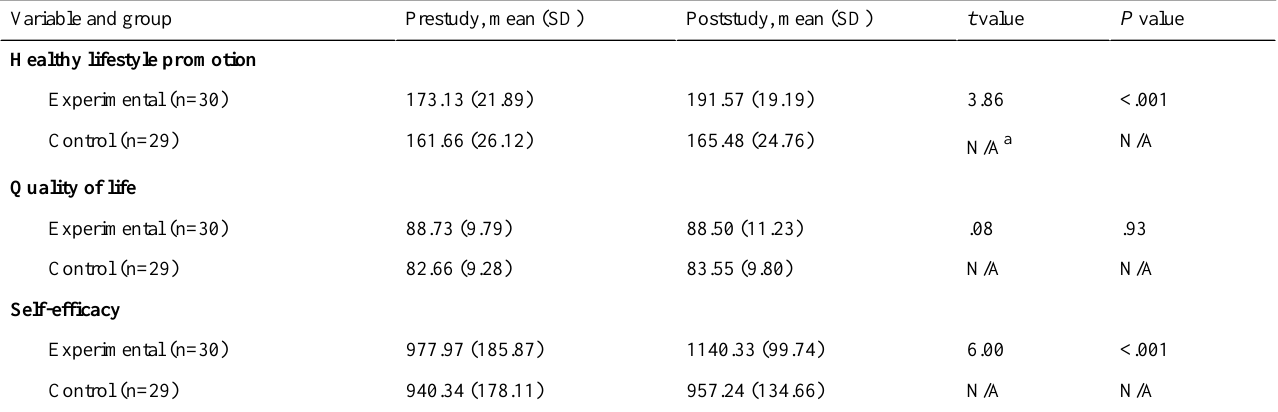
Table 1. Comparison of psychosocial indicators between the experimental and control groups.